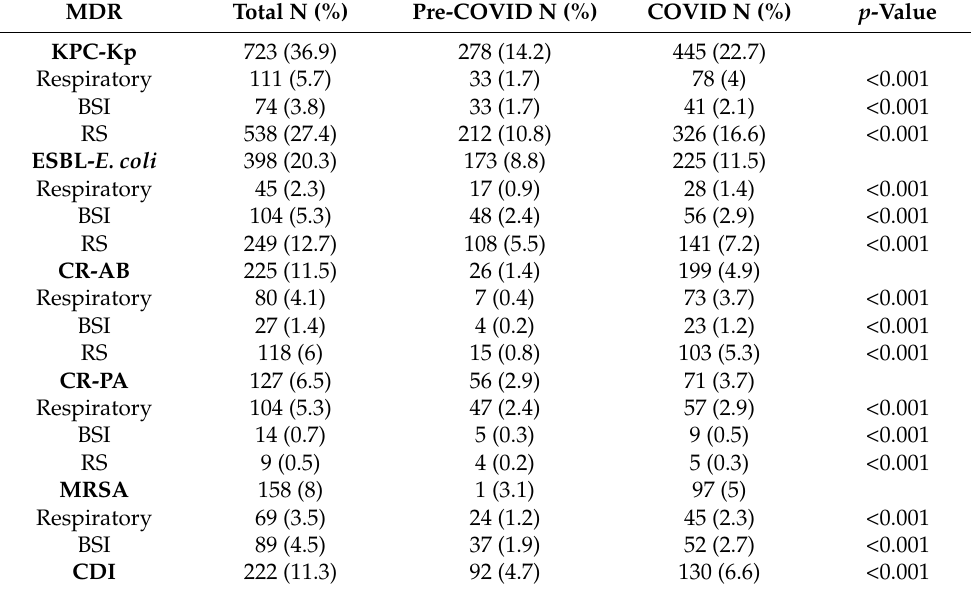
Table 1. MDR isolates pre- and during COVID.